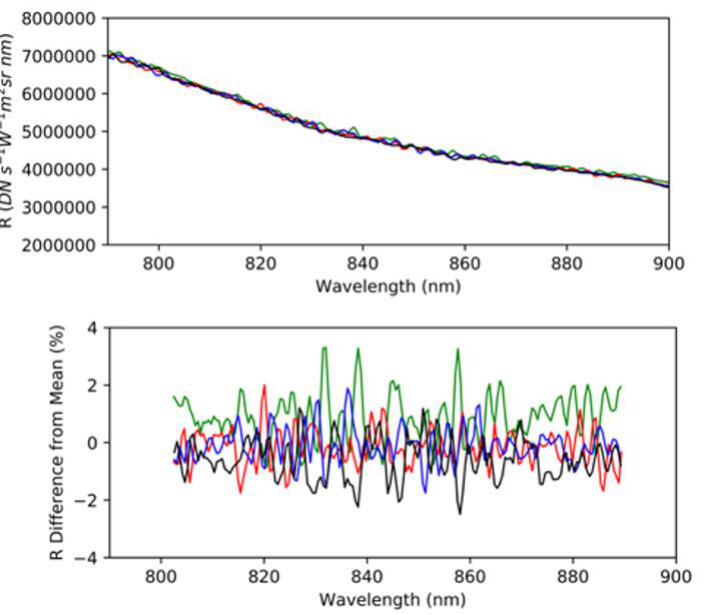
Figure 17. The SOLARIS gain results based on four individual spectral scans from 780 nm to 920 nm with